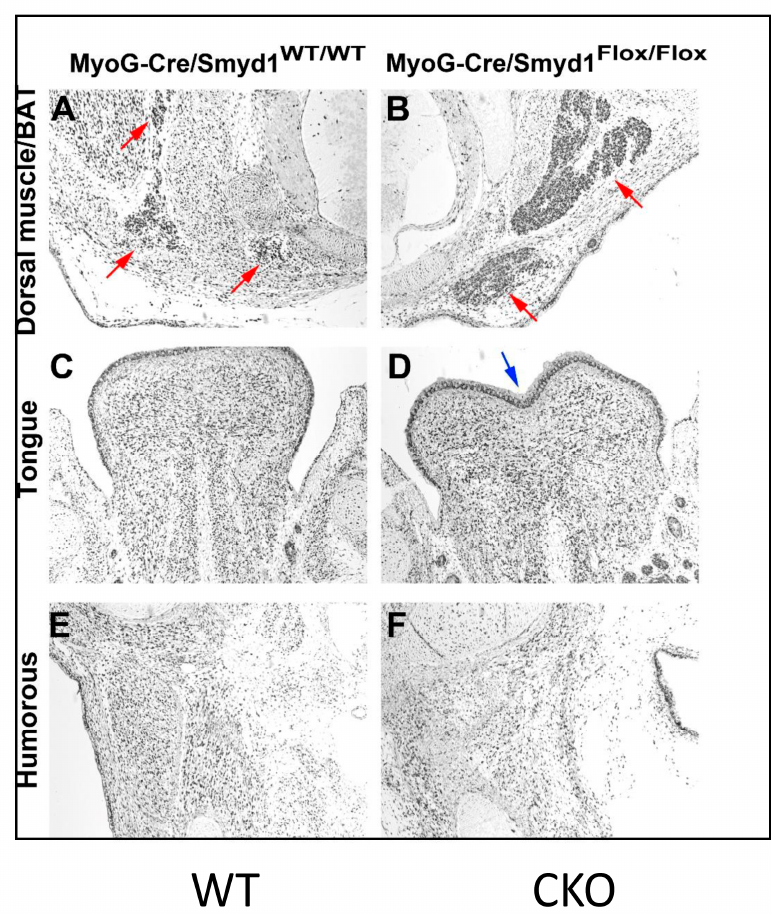
Figure 3. MyoG-Cre -induced Smyd1 CKOs have proliferative defects and non-autonomous deposits of brown adipose tissue. ( A , B ). Reduced proliferation within E14.5 embryonic tissue and accumulation of brown adipose tissue (BAT, pink arrows) within dorsal muscles as detected by reduced Ki67 staining in CKO. ( C , D ) Proliferation differences within the epidermal region at the tip of the CKO tongue. The line of proliferation lags in the CKO ( D , blue arrow) as compared to WT ( C ). ( E , F ) Insignificant proliferative differences within humerus muscles of WT and CKOs.